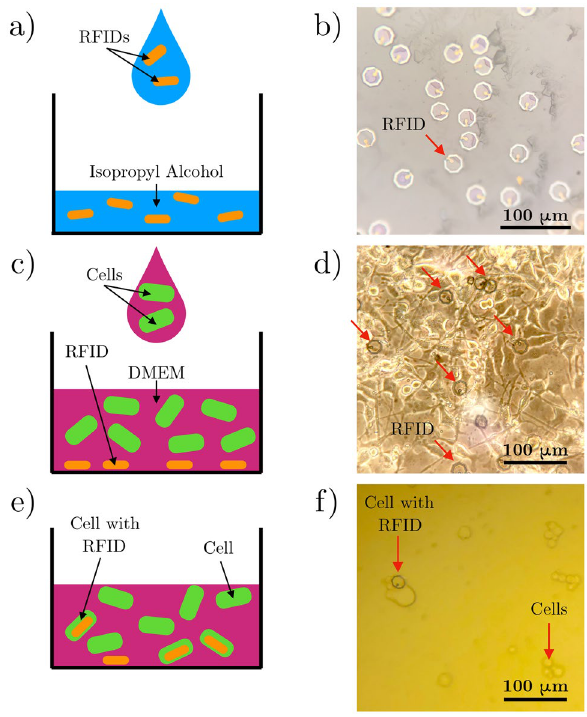
Figure 3. RFID internalization process procedure. ( a ) Drop an aliquot of the RFID solution into a cell well. ( b ) Once the isopropyl alcohol evaporates, the RFIDs remain at the well bottom. ( c ) Dispense a suspension of cells on top of the RFIDs. ( d ) After 24 h, many RFIDs are internalized inside the cells. In this microscope image of cultured cells, the arrows point to the RFIDs. ( e ) Dissociate the cells and RFID culture with Trypsin, as described in the methods section. ( f ) The result is a suspension of cells and cells with implanted RFIDs.